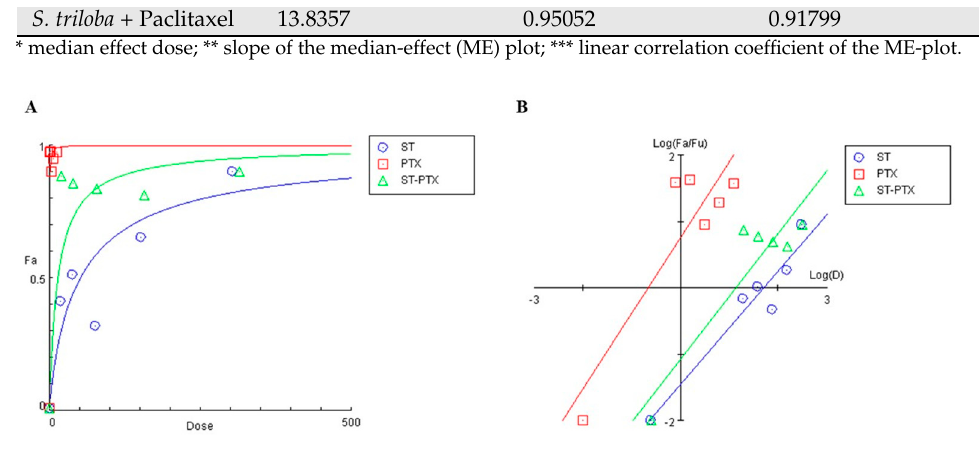
Table 4. Median effect dose for SKOV3 cells.